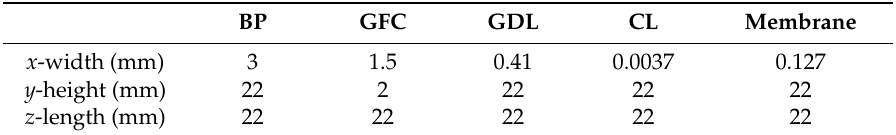
Figure 1. Geometry and mesh of a single cell proton exchange membrane (PEM) fuel cell. Table 1. The cell geometric dimensions [25].